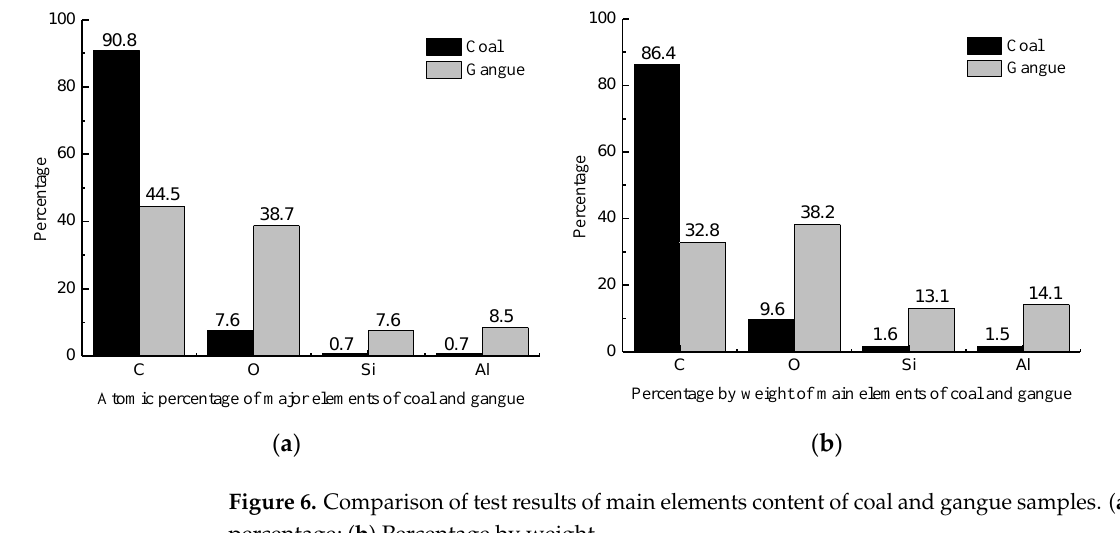
Figure 6. Comparison of test results of main elements content of coal and gangue samples. ( a ) Atomic percentage; ( b ) Percentage by weight.